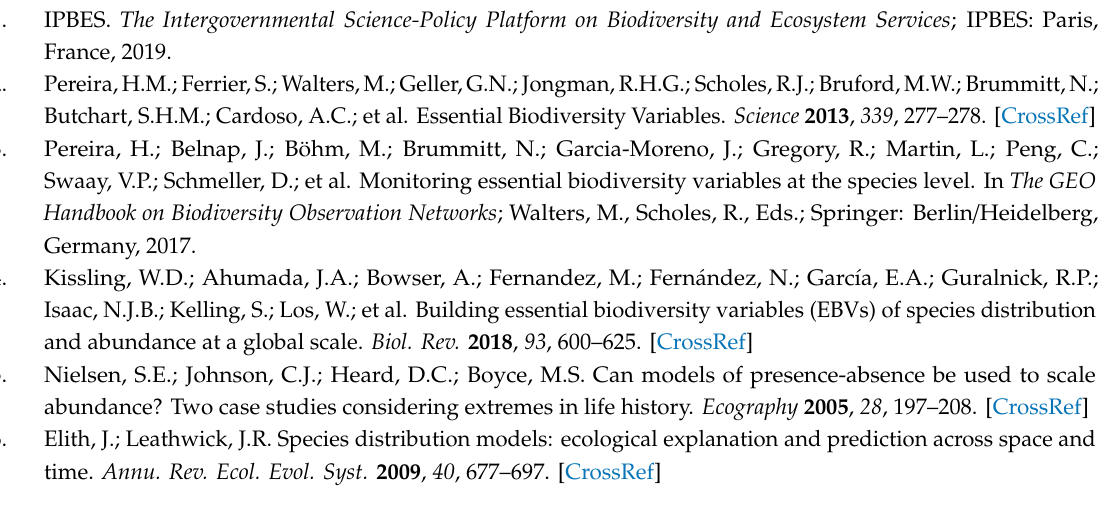
Figure S1 : Correlation matrix (a) and variance inflation factors (VIF) plot (b) for variables used in model fitting. Figure S2 : Frequencies of predicted abundance per year for the period 2001–2016. Red line shows the median of the distribution values. Figure S3 : Inter-annual spatial variability of the predicted abundance of Iris boissieri based on ecosystem functional attributes (EFAs). Figure S4 : Correlation matrix between the mean, the standard-deviation, and the coe ffi cient of variation of predicted abundance (Prjm, Prjsd, and Prjcv, respectively), and the three predictors included in model fitting (EVImin, EVIdmic, and SLO). Figure S5 : Quantile regression plot fitted to the median (quantile = 0.5) representing the relation sign between the annual mean of predicted abundance, aggregated by year, and the averaged total burned area (TBA). Figure S6 : Quantile regression plots fitted to the median (quantile = 0.5) representing the relation sign between the annual mean of predicted abundance, aggregated by year, and the average of each climatic variable (and anomalies) for the whole study area. Table S1 : Summary of the full sets of predictors used to calibrate abundance models. Table S2 : Final sets of predictors used to calibrate GLMs for Iris abundance in the Peneda-Ger ê s National